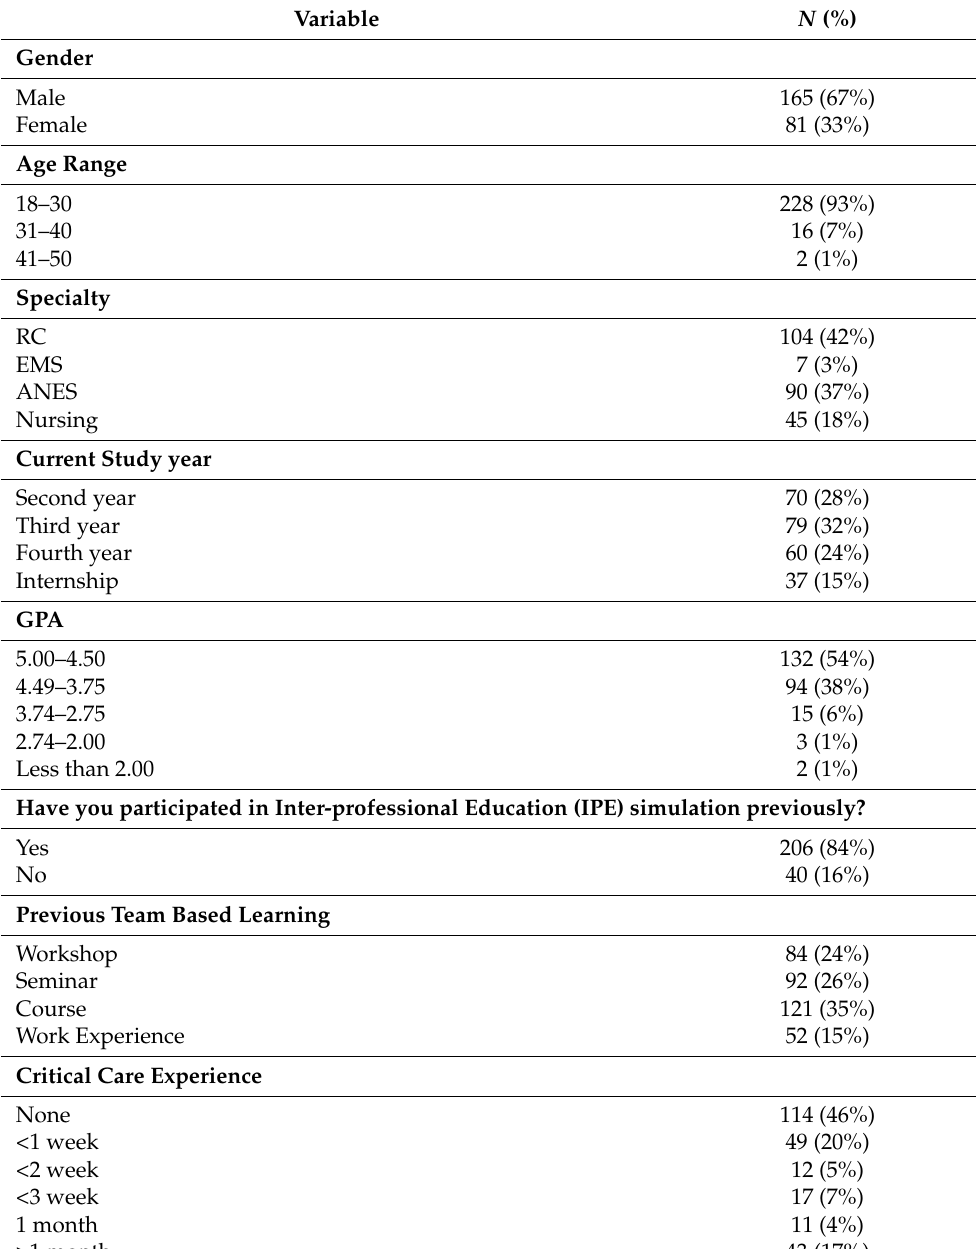
Table 1. Demographics and background characteristics of the students ( N =